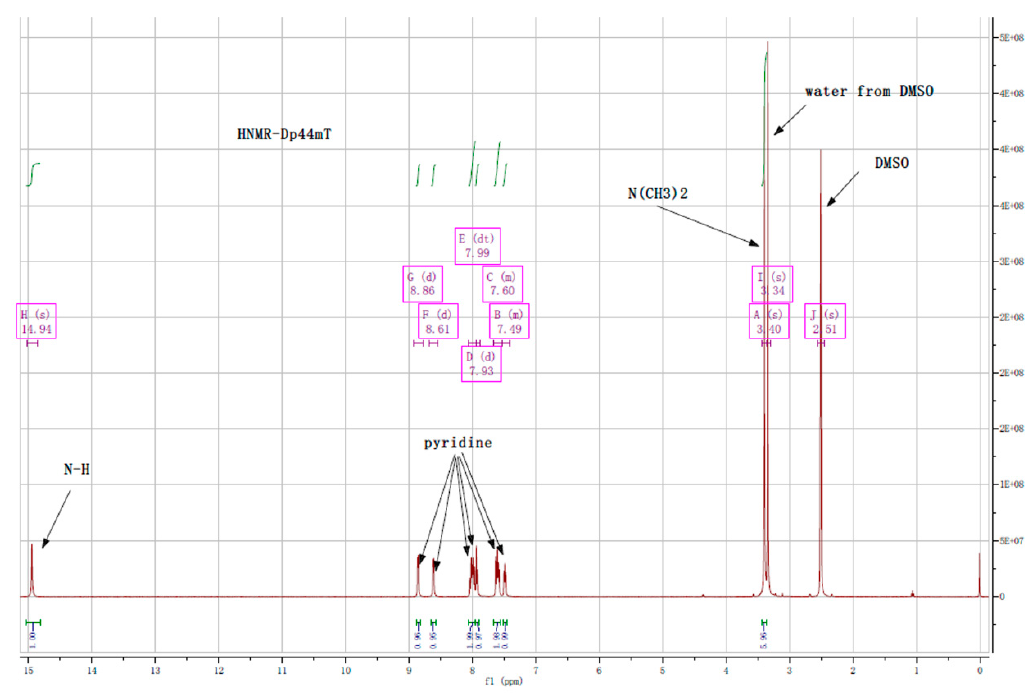
Figure C3. 1 H-NMR of Dp44mT and peak assignment.